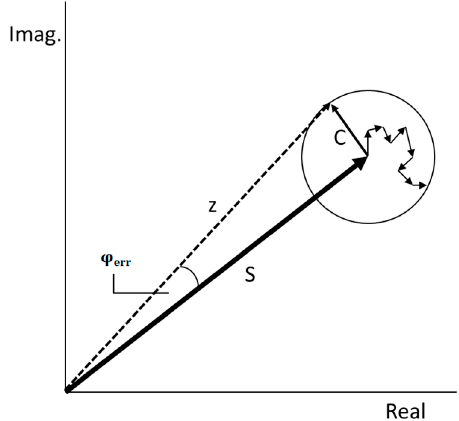
Figure 1. The backscattered signal from a pixel is a complex sum of each scatterer within the pixel, represented here by the vector z . A PS within the pixel is represented by the vector S = σ T and the complex sum of the background clutter by the vector C = < σ C > . The angle ϕ err subtended by z and S is the phase error due to the superposition of the clutter. Redrawn from [23,24].